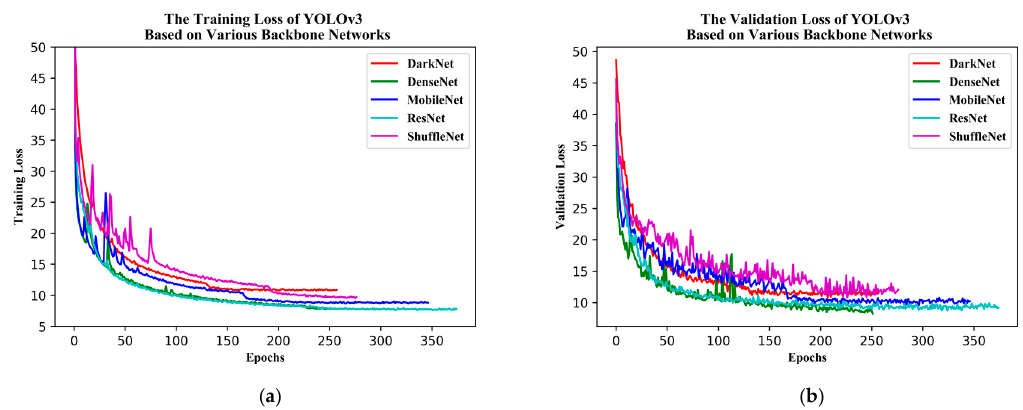
Figure 9. ( a ) Training and ( b ) validation loss of YOLOv3 based on various backbone networks.